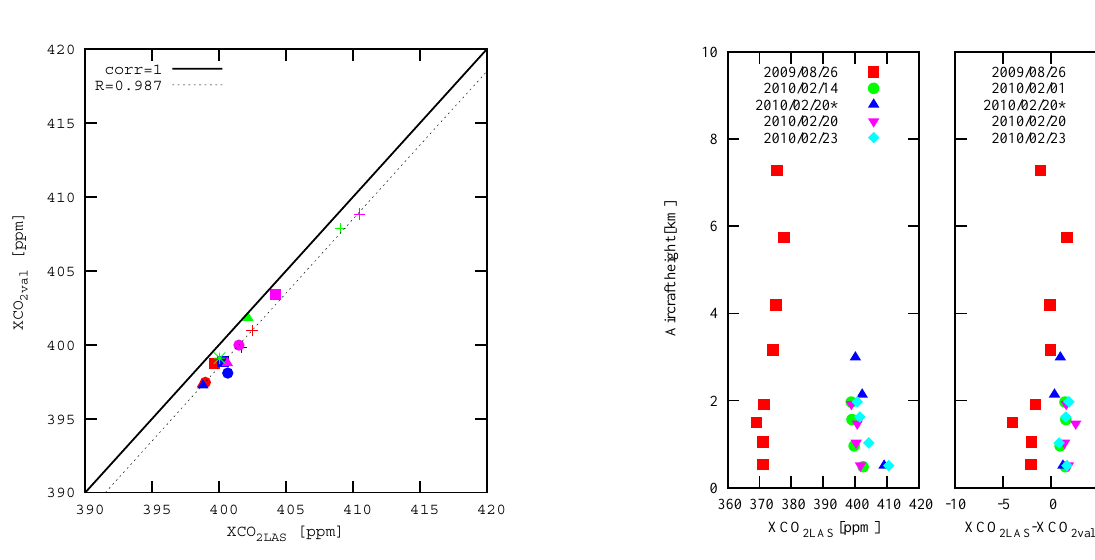
Fig. 8. Correlation between measured and calculated XCO 2 from the ground to the aircraft height. Asterisk ( ∗ ): 10000ft, trian- gle ( 4 ): 6500ft; circle ( (cid:13) ): 5000ft; square ( (cid:3) ): 3300ft; cross point (+): 1600ft. Red: 14 February (Tsukuba); Green: 14 Febru- ary (Koganei); Blue: 20 February (Tsukuba); Purple: 23 February (Tsukuba).